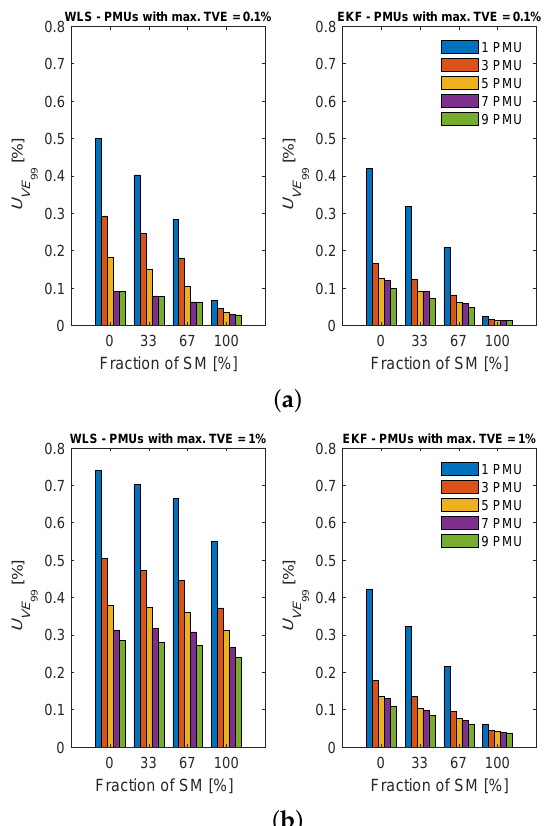
Figure 7. 99-th percentiles of the relative vector estimation errors returned by the WLS algorithm (on the left) and the EKF (on the right), when the weight of real-time SMs on the measurement variance of power injections increases from 0% (scenario 1) to 100% (scenario 4). In ( a , b ), the maximum TVE of the deployed PMUs is set to 0.1% and 1%, respectively. In both ( a ) and ( b ) from 1 to 9 PMUs are used and the load fluctuations lie within ± 60%, of the nominal